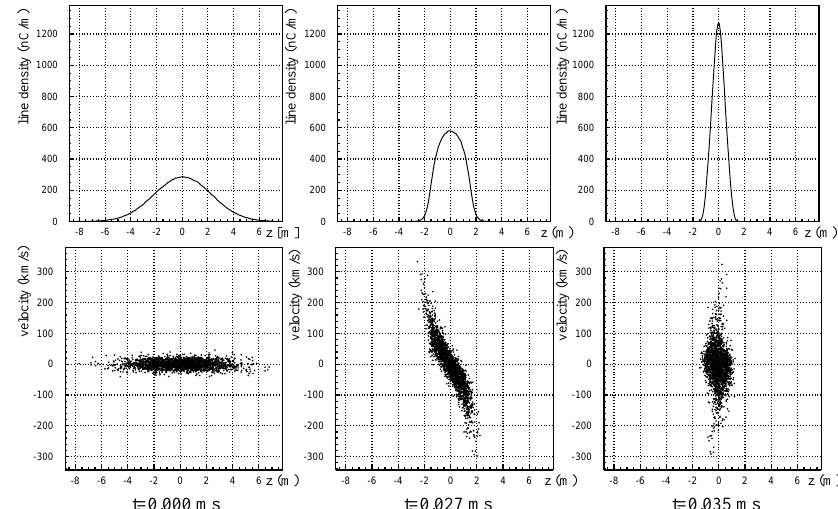
FIG. 8. Line density and scatter plot of longitudinal phase space for Gaussian bunch with h (cid:1) 2 0.05 at different phases of compression.